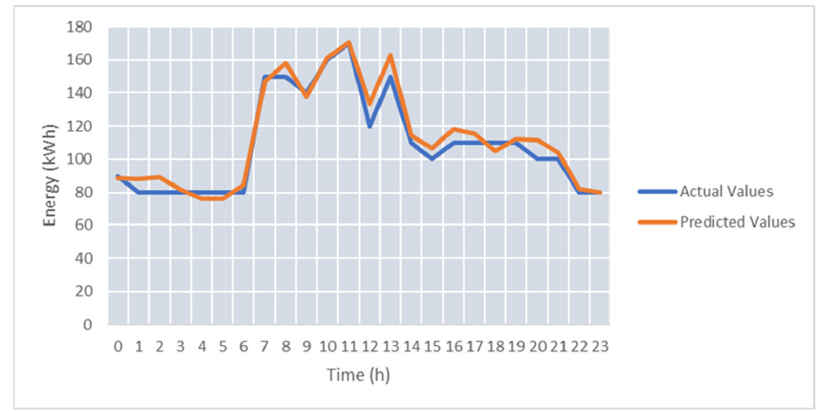
Figure 14. TC-M1: best predicted day (SMAPE = 4.8%).